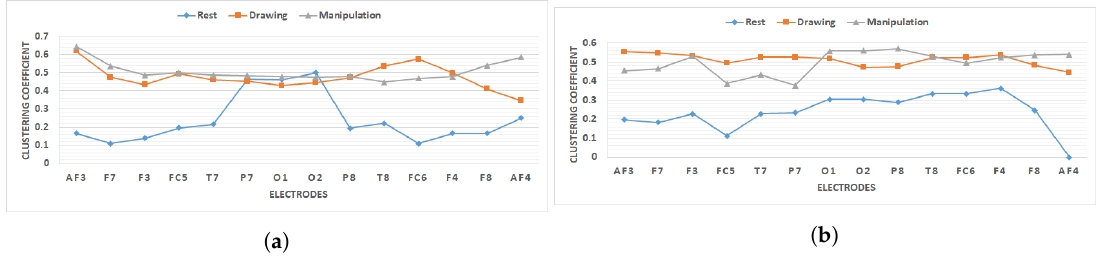
Figure 12. Clustering coefficient of all electrodes for novice and expert users during rest, drawing and manipulation states. ( a ) User 3 (A representative novice user). ( b ) User 8 (A representative expert